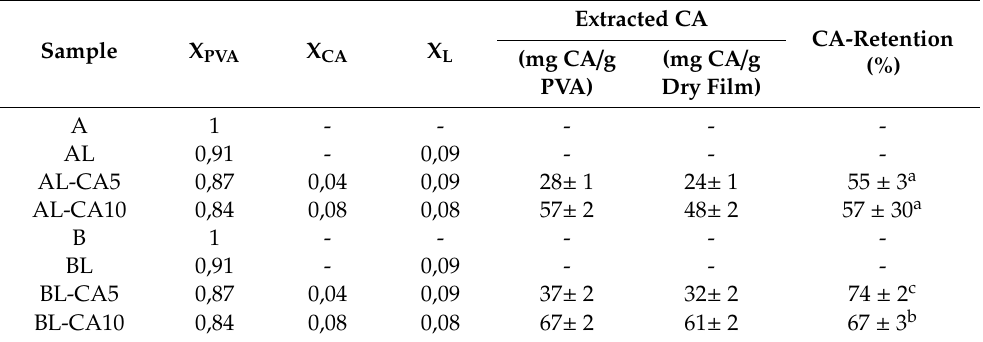
Table 1. Nominal mass fraction (x) of the di ff erent components of the films, extracted carvacrol in the final film, and its retention percentage. Mean values and standard